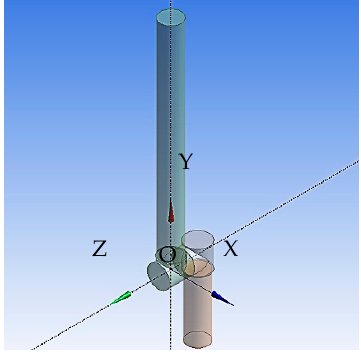
Figure 1. Manipulator model and coordinate system.